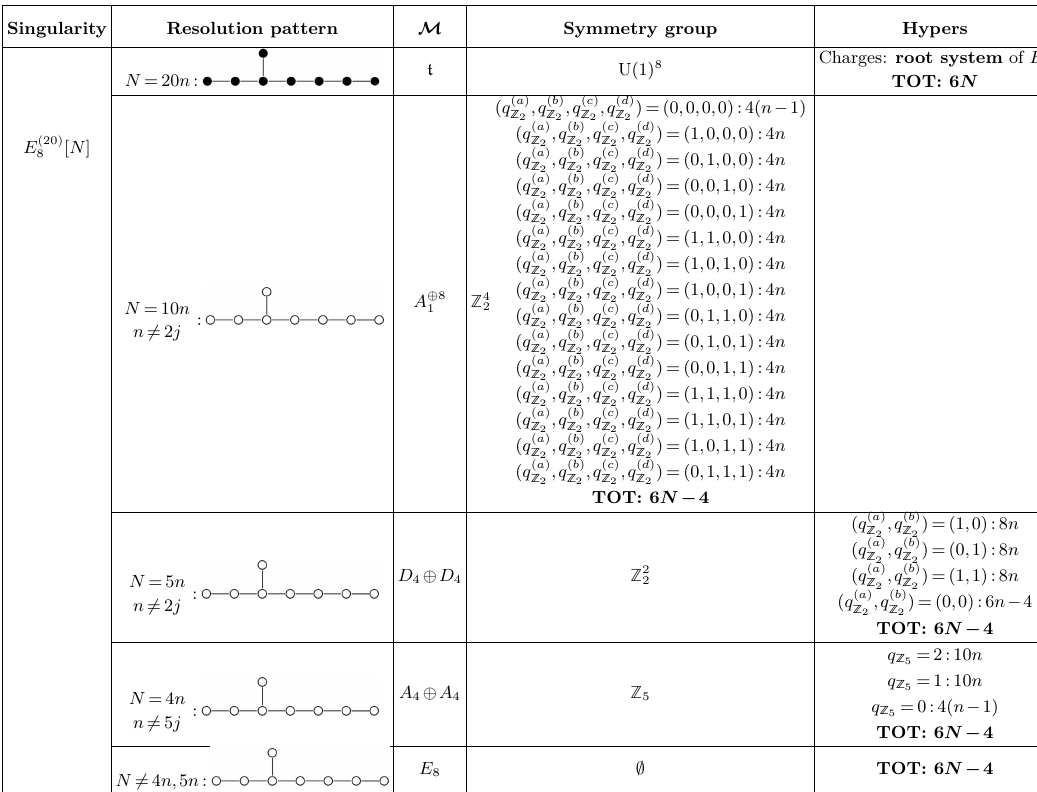
Table 10 . Higgs branch data for quasi-homogeneous cDV singularities of E (20)